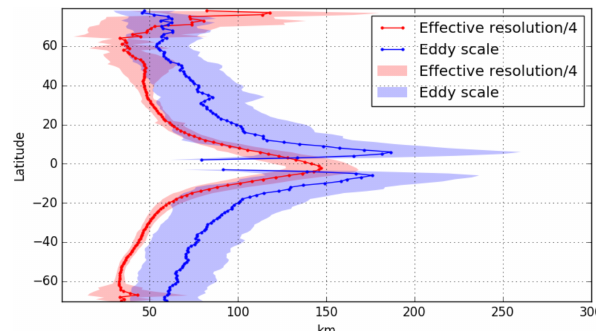
Figure 8. Zonally averaged eddy scale (as in Chelton et al., 2011; and computed from the DUACS-DT2018 two satellites maps) and feature radius resolution of the mesoscale structures that can be properly mapped in DUACS (i.e., derived as 0.25 × effective res- olution). Units in